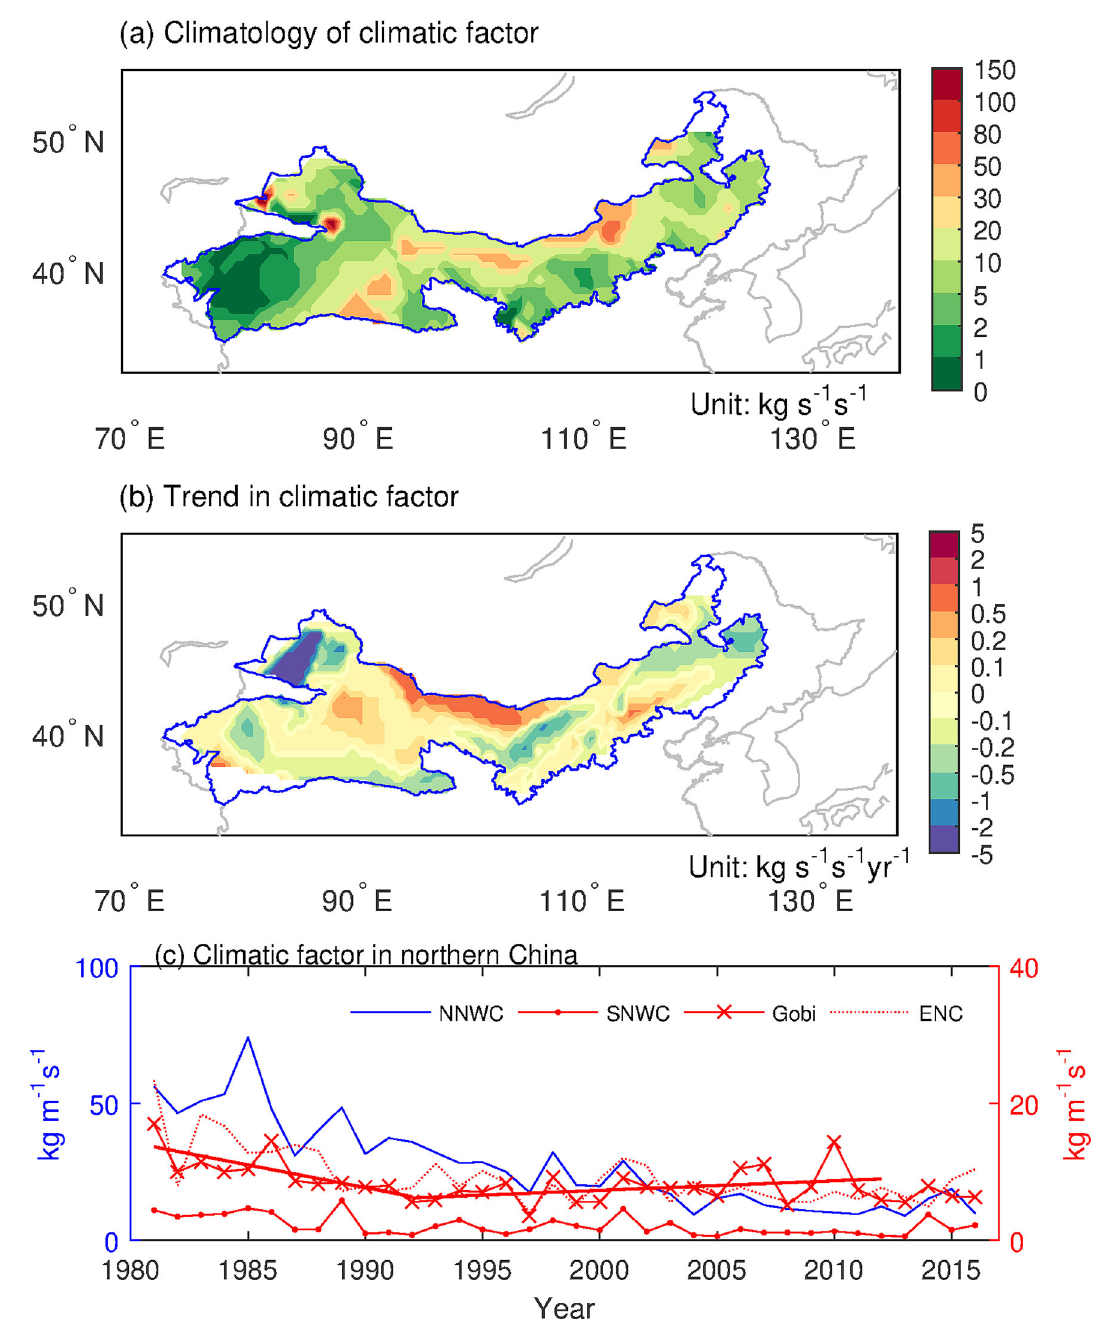
Fig. 5 Spatial distribution of climatological climatic factor ( a ) and trend in climatic factor ( b ) in northern China during spring from 1981 to 2016. ( c ) Shows the time series of spring climatic factor over the southern Northwest China (SNWC), northern Northwest China